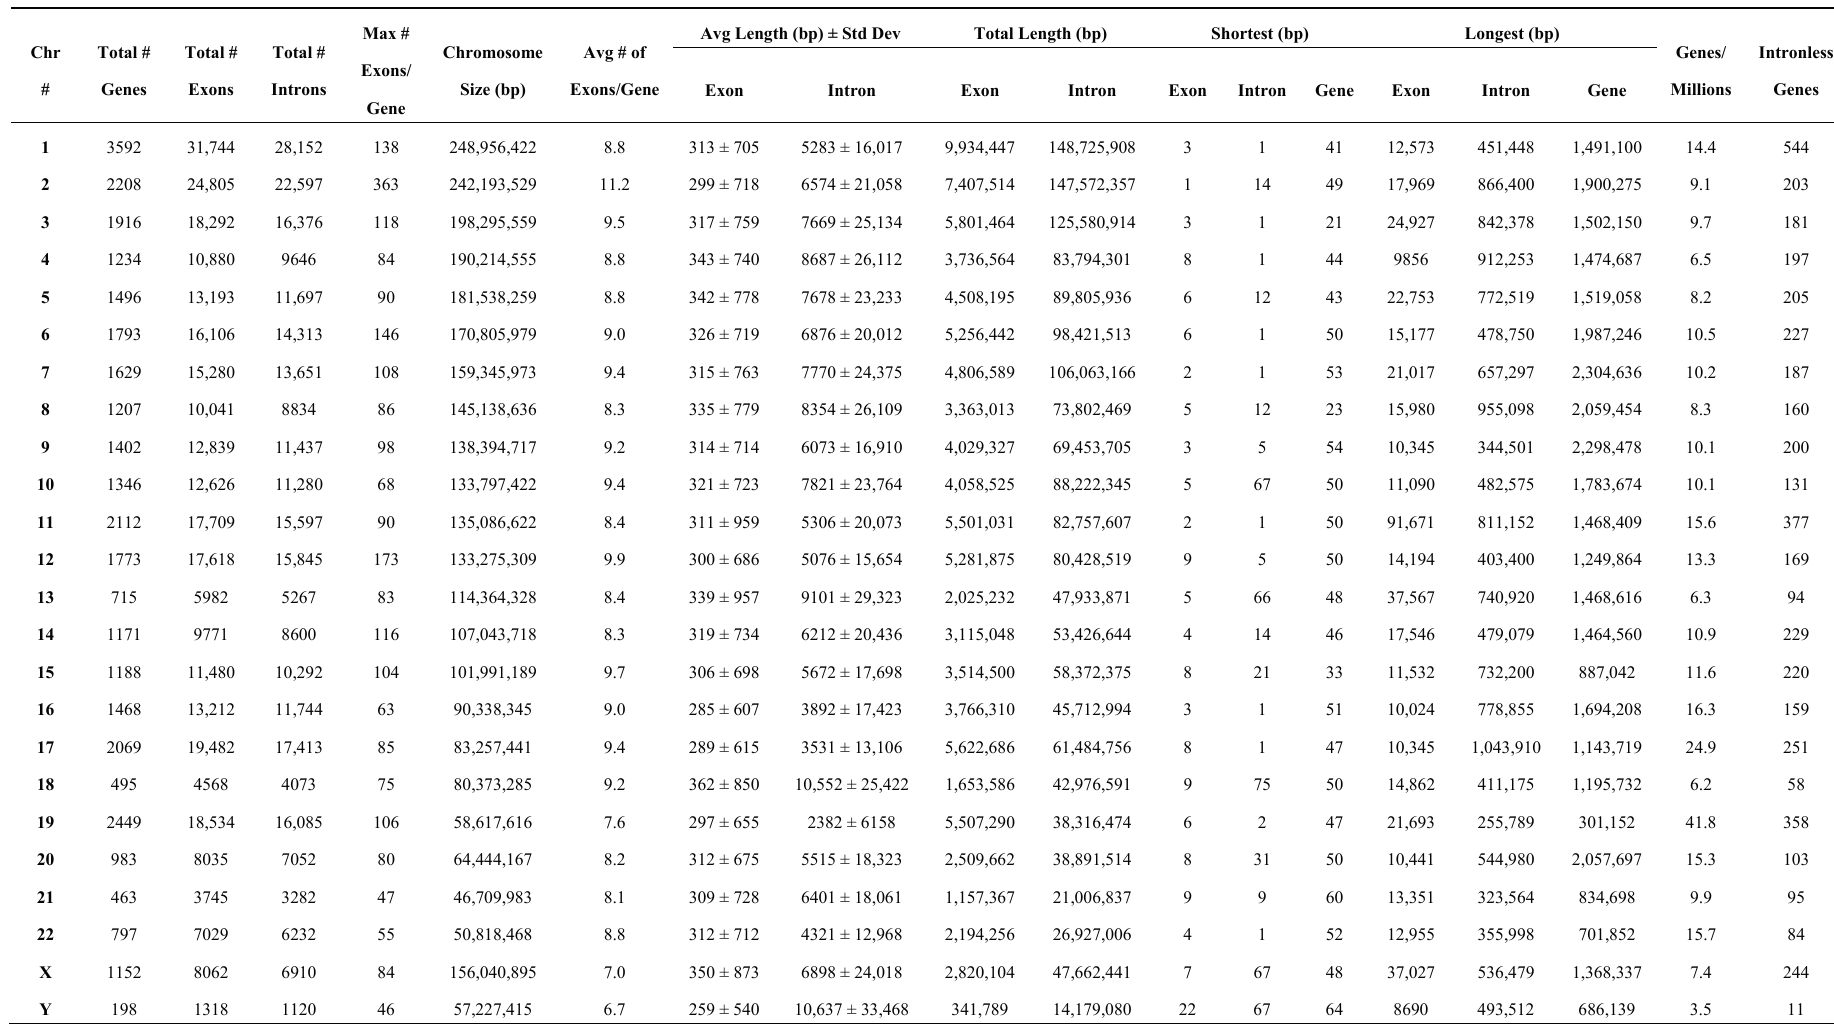
Table 1. Distribution of exons and introns across human chromosomes. Human genome dataset was downloaded from the UCSC main table browser (GCRh38, December 2013 build). Data was processed using tabular software. Analysis was performed using the 34,856 genes containing 312,351 exons and 277,495 introns. Caution: introns with the length <30–40 nt likely reflect artifact or error (see